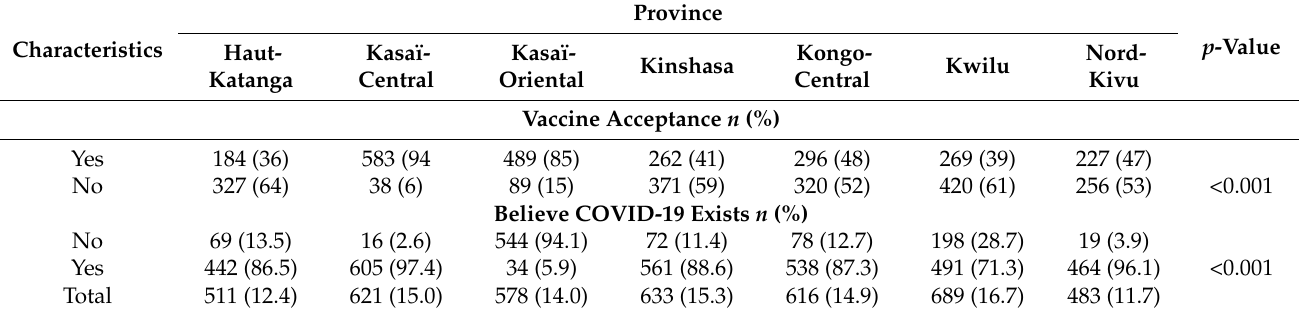
Table 2. COVID-19 vaccine acceptance and beliefs on COVID-19 existence by provinces.